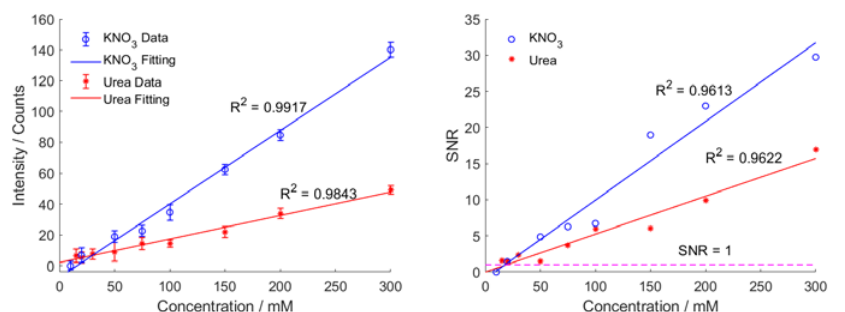
Figure 12. ( a ) Calibration curves and ( b ) SNR curves of aqueous urea and potassium nitrate solutions. The average and standard deviation for each solution are obtained over 10 measurements. According to the SNR curves, the NEC of our setup for urea and KNO 3 are 19 and 18 mM, respectively.